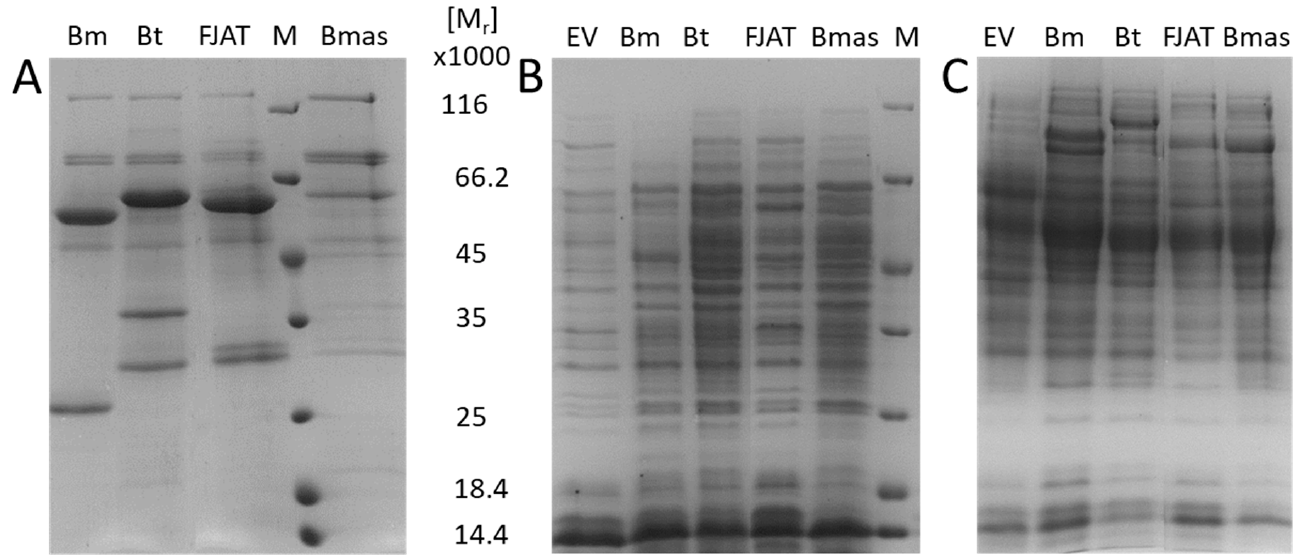
Figure 5. SDS-PAGE analyses of extra- and intracellular proteins during the recombinant production of PGAs with P. megaterium . Recombinant P. megaterium carrying the plasmids for production of PGAs from P. megaterium (pALBm1, Bm), B. thermotolerans (pRBBm311, Bt), B . sp. FJAT-27231 (pRBBm316, FJAT), and B. massiliogorillae (pRBBm317, Bmas), respectively, were cultivated aerobically at 37 ◦ C, recombinant protein production was induced, and samples were taken for the analyses of extra- ( A , 22 h after induction) and intracellular ( B + C , 3 h after induction) proteins. Intracellular proteins were further separated in soluble ( B ) and insoluble ( C ) fractions. P. megaterium carrying an empty vector (EV) served as control. M: protein molecular weight marker.